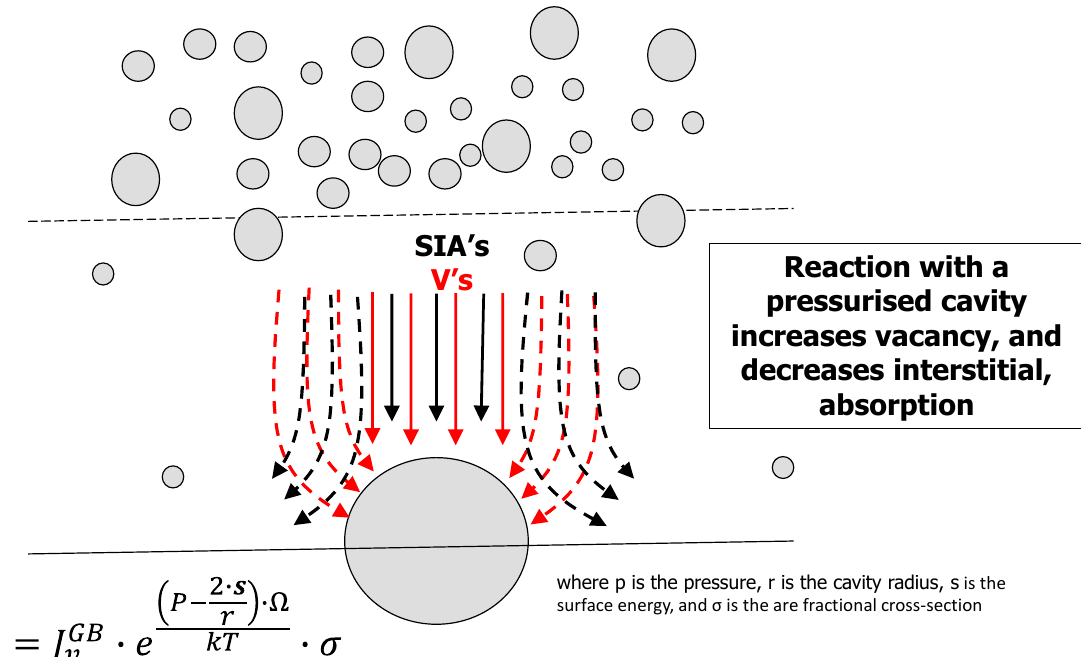
Figure 12. Schematic diagram illustrating source of vacancy and interstitial point defect flux to grain boundaries. There is a higher vacancy, relative to interstitial, flux from the grain interior. The flux to cavities is a function of the point defect flux to the boundary and an interaction term. p is the pressure, r is the cavity radius, 𝑠 is the surface energy, and σ is the area fractional cross-section.